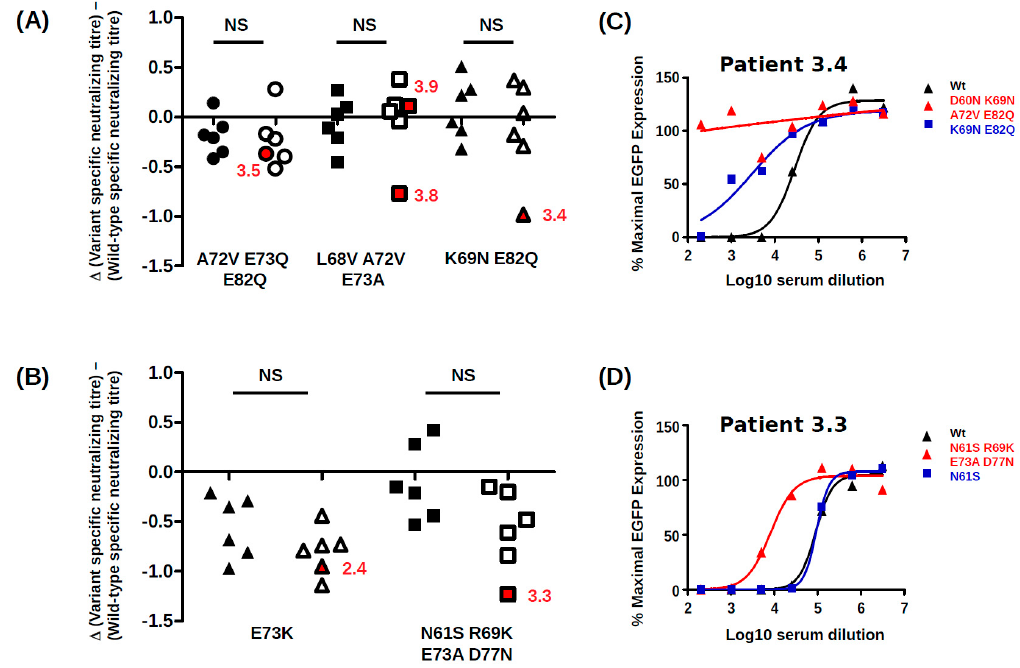
Figure 7. Impact of BC-loop mutations on neutralization by sera from controllers and non-controllers. Neutralizing titres in controller ( n = 6, filled symbols) and non-controller ( n = 6, open symbols) sera at 12 months post-KTx were measured against PSV carrying wild type VP1 and different VP1 variants. Experiments were performed in 293TT cells. For each serum, the log10 neutralizing titre against the wild-type virus was subtracted from the log10 neutralizing titre against the VP1 variant measured at the same PSV dose, and the result is plotted for each PSV variant. ( A ) genotype Ib2 variants; ( B ) genotype IVc2 variants. Red symbols and adjacent patient codes indicate the cognate non-controller serum for each VP1 variant. Input PSV doses were 500 pEGFP copies / cell for Ib2-V 72 Q 73 Q 82 and Ib2-V 68 V 72 A 73 , 200 pEGFP copies / cell for Ib2-N 69 Q 82 and 100 pEGFP copies / cell for genotype IV variants. ( C ) Neutralization curves for wild-type Ib2-E73E82, Ib2-N 69 Q 82 and Ib2-N 60 N 69 V 72 Q 82 PSV in serum from patient 3.4 at 12 months post-KTx. ( D ) Neutralization curves for wild-type IVc2, IVc2-S 61 and IVc2-S 61 K 69 A 73 N 77 PSV in serum from patient 3.3 at 12 months post-KTx.